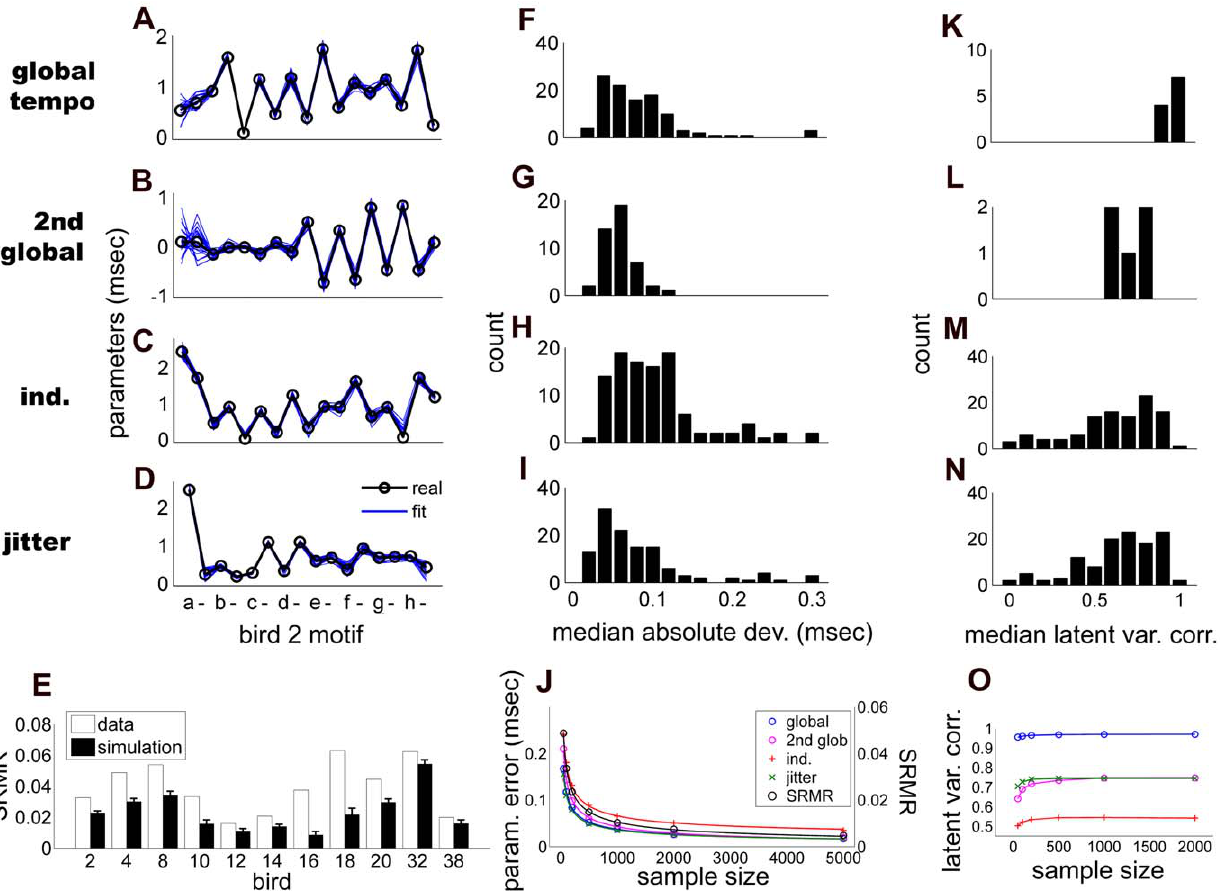
Figure 6. Results of Monte Carlo simulations based on real parameter distributions in the song data. For plots A-D, F-I and K-N, parameter type is designated by labels on the far left. A-D, Real parameter values (black lines), along with parameter estimates from 20 randomly selected simulations (blue) for one bird. E, Median SRMR across simulations for each bird (black bars, errorbars indicate median absolute deviation) vs. SRMR values from the real data (white bars). F-I, Median absolute deviation in parameter estimates from real parameters across all birds. J, Parameter error and SRMR as a function of sample size for simulations selected from 3 birds. Here, parameter error was taken as the median MAD across simulations and birds. Solid lines represent a regression of error and SRMR with the square root of sample size. K-N, Distribution of Pearson’s correlation between the real and simulated latent variables. O, Median latent variable correlation from the same 3 birds taken as a function of sample size. Color legend is the same as in panel